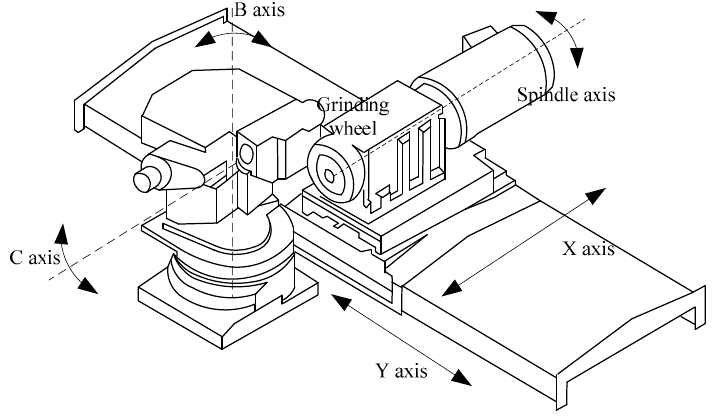
Figure 1. Structure of CNC batch grinding machine tool.